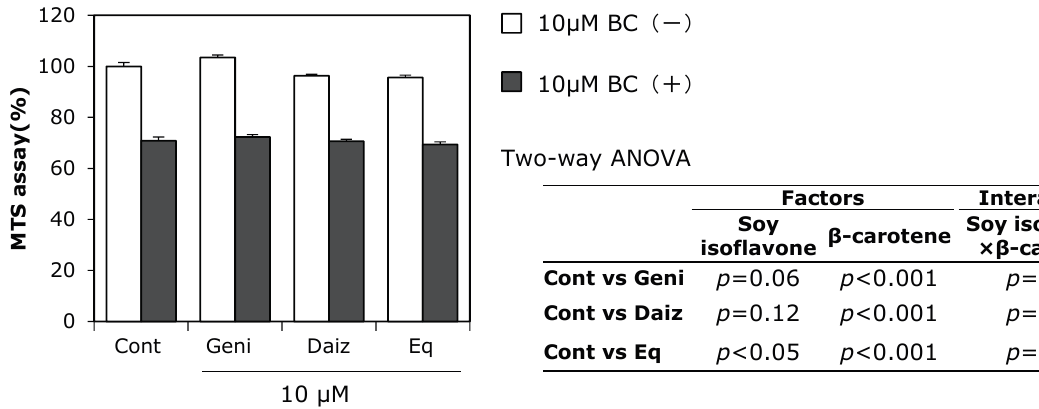
Figure 3. Combined effect of soy isoflavones with β -carotene on cell growth. MC3T3-E1 cells were precultured in α -MEM with 10% FBS for 24 h and subsequently cultured in medium with 10% charcoal-treated FBS containing 10 μ M of soy isoflavones with (black bars) or without (open bars) 10 μ M of β -carotene for three days. Cell growth was evaluated using the MTS assay. Data are expressed as means ± SEM ( n = 6). Statistical analysis was performed using two-way ANOVA with the two factors being soy isoflavones (control: Cont., daidzein: Daiz., genistein: Geni., and equol: Eq.) and β -carotene